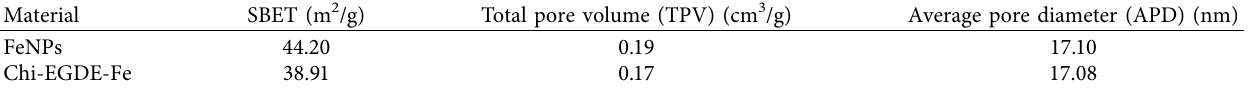
Table 2: Specific surface area, volume, and pore size parameters of the studied materials.